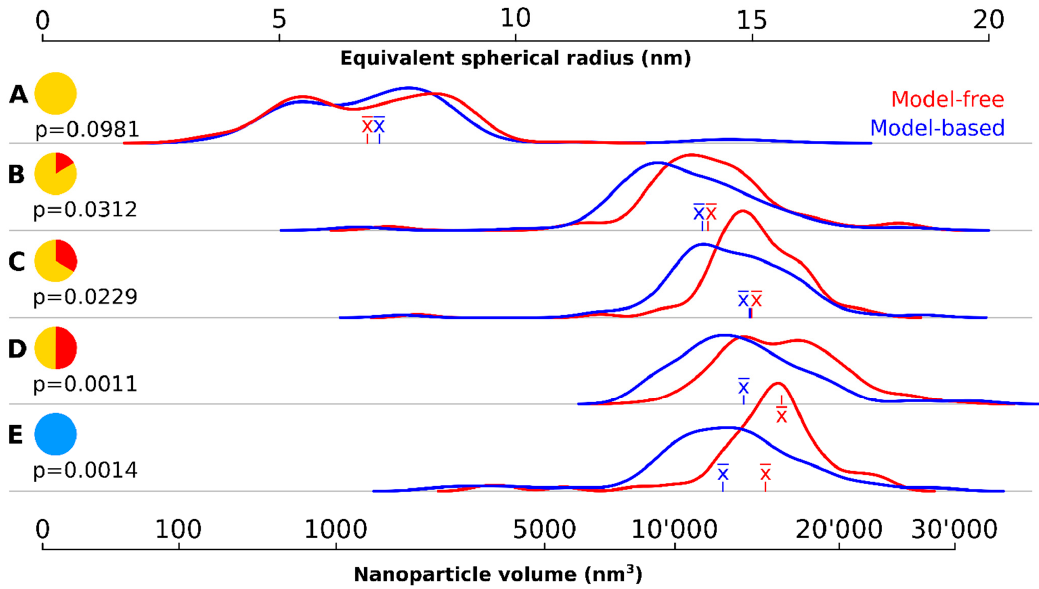
Figure2. Densitykernelplotsoftheparticlesizeatdi ff erenttimepointsusingtwodi ff erentquantification Figure 2. Density kernel plots of the particle size at different time points using two different methods. ( A ) at the onset of the 320 ◦ C plateau; ( B ) after 10 min at 320 ◦ C; ( C ) after 20 min at 320 ◦ C; quantification methods. ( A ) at the onset of the 320 °C plateau; ( B ) after 10 min at 320 °C; ( C ) after 20 min at 320 °C; ( D ) after 30 min at 320 °C; ( E ) after cool down to room temperature. The time is ( D ) after 30 min at 320 ◦ C; ( E ) after cool down to room temperature. The time is symbolized on the left of symbolized on the left of each time point. The red curves show the particle volume distribution using each time point. The red curves show the particle volume distribution using the model-free, stereological the model-free, stereological volume estimator. The blue curves correspond to model-based volume estimator. The blue curves correspond to model-based calculations of the equivalent spherical calculations of the equivalent spherical radius using 2D image profiles (assuming a spherical particle). radius using 2D image profiles (assuming a spherical particle). The mean ( x ) is shown in the respective color of the curve for each time point. The p values correspond to a Student’s t-test statistic describing the di ff erences between the two curves at each time